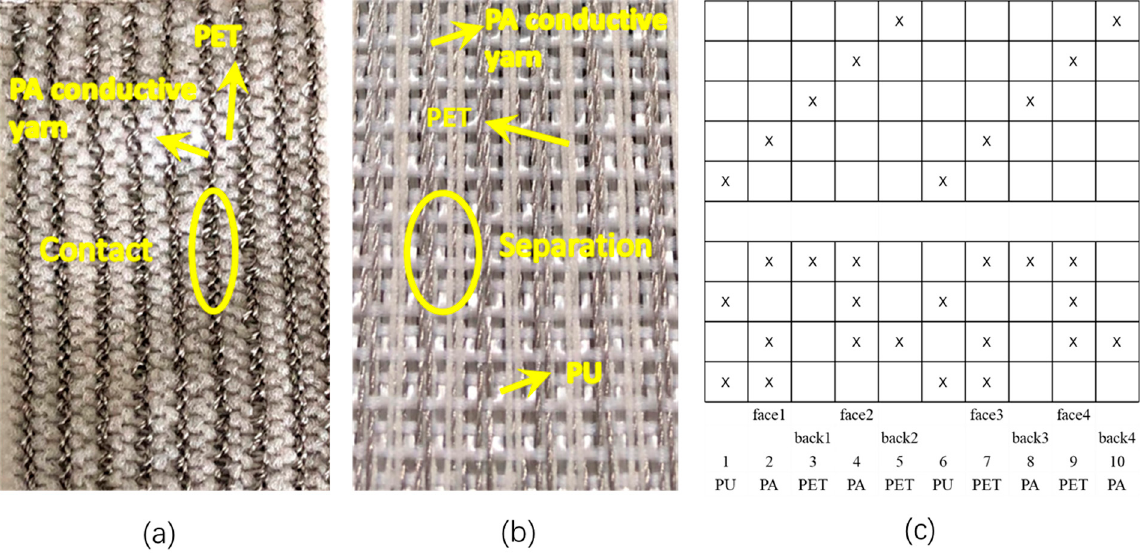
Figure 2. ( a ) Photographs of 3DWE-TENG before the stretch; ( b ) Photographs of 3DWE-TENG before and after stretch; ( c ) Stitching double weave diagram. and after stretch; ( c ) Stitching double weave